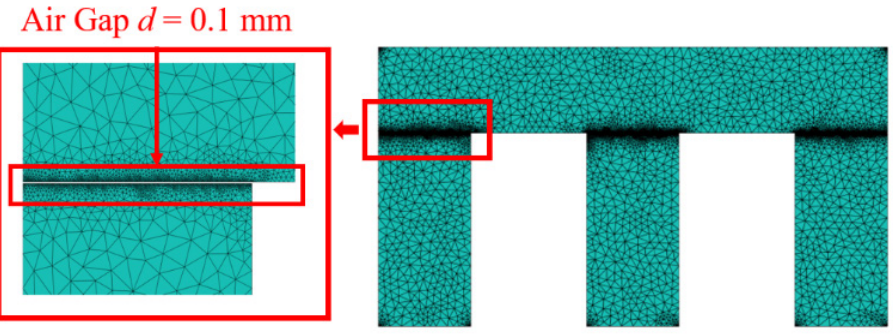
Figure 2. Mesh of the half section of the magnetic core used in finite element analysis.